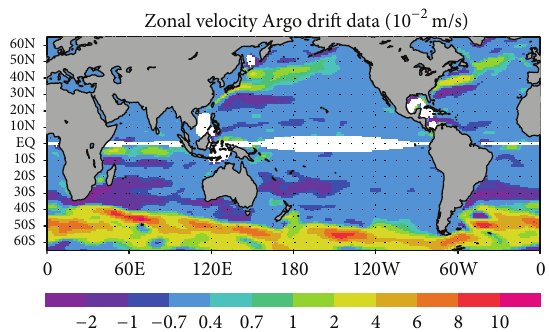
Figure 2: Estimated mean zonal velocity during 2001–2007 at a depth of 1000 m in the GY case.